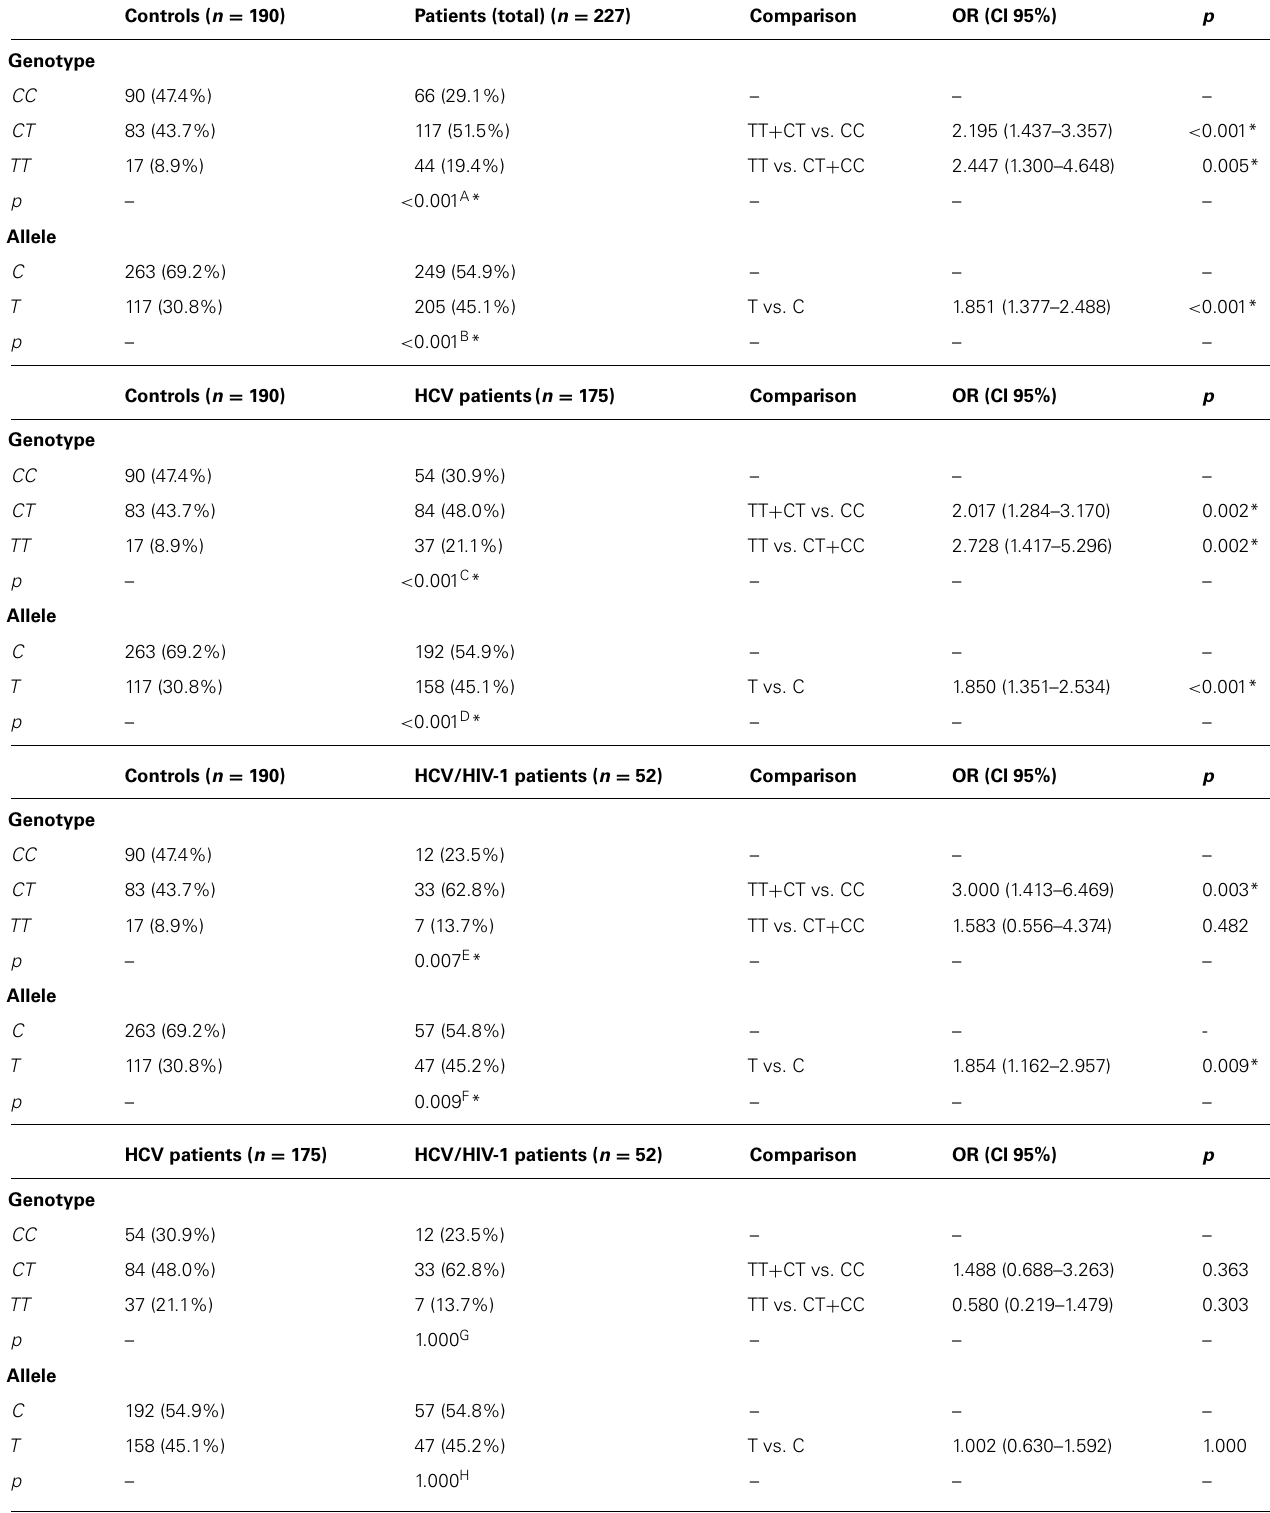
Table 2 |Allelic and genotypic frequencies and association analysis –